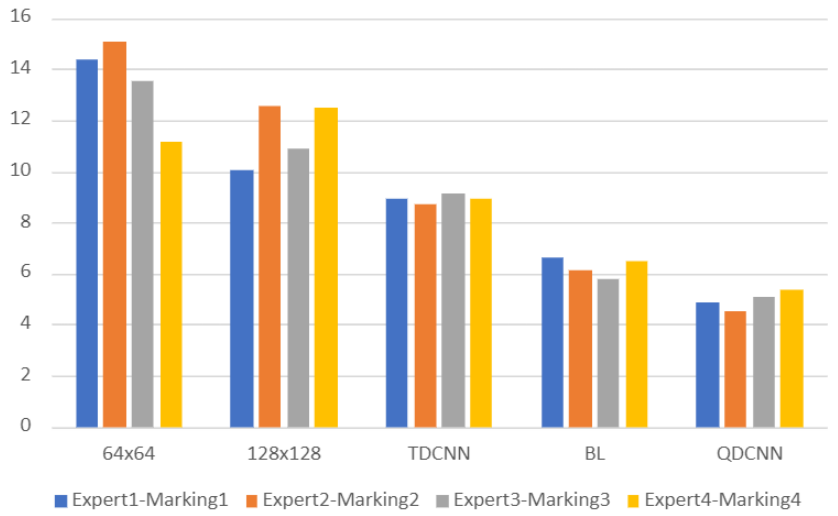
Figure 10. MAVD values between five models and the markings of two experts on AUS images at two different